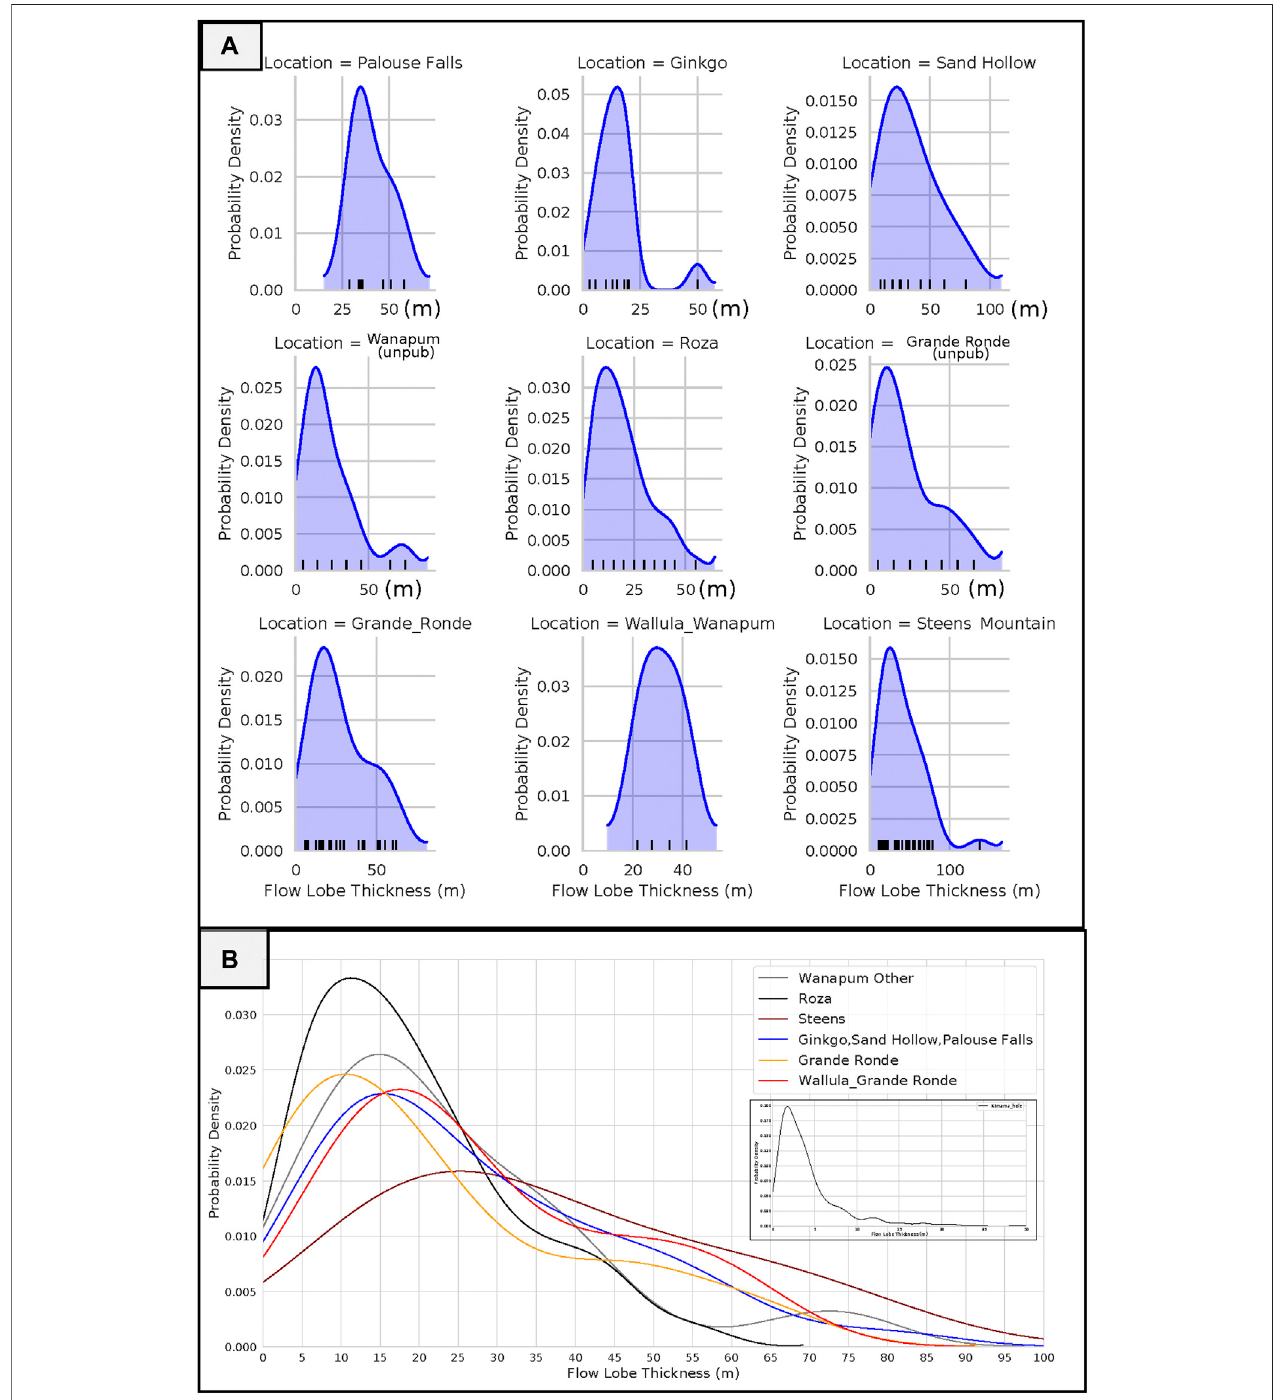
FIGURE 8 | (A) Plots of univariate kernel density estimators to calculate PDF of lava lobe thicknesses for individual Wanapum Formation eruptive fl ow- fi elds (Palouse Falls; Gingko; Sand Hollow; Roza), Wanapum Formation data collectively, and Grande Ronde and Wallula Grand Ronde Formations; both the latter plots are Grande Ronde Basalt Formation (see text) from the Columbia River Basalt Province. (B) Summary PDFs of lava lobe thicknesses for individual Wanapum eruptive fl ow- fi elds (Palouse Falls; Gingko; Sand Hollow; Roza), Wanapum Formation data collectively, and Grande Ronde and Wallula Grand Ronde plots, which are Grande RondeBasaltFormation (seetext).( B ,inset)showsplotofunivariatekerneldensity estimators tocalculatePDF oflobethicknessesforlavasofKimamaBorehole,Snake River Plain (after Potter et al., 2019); note thinness cf . Columbia River Basalt data.